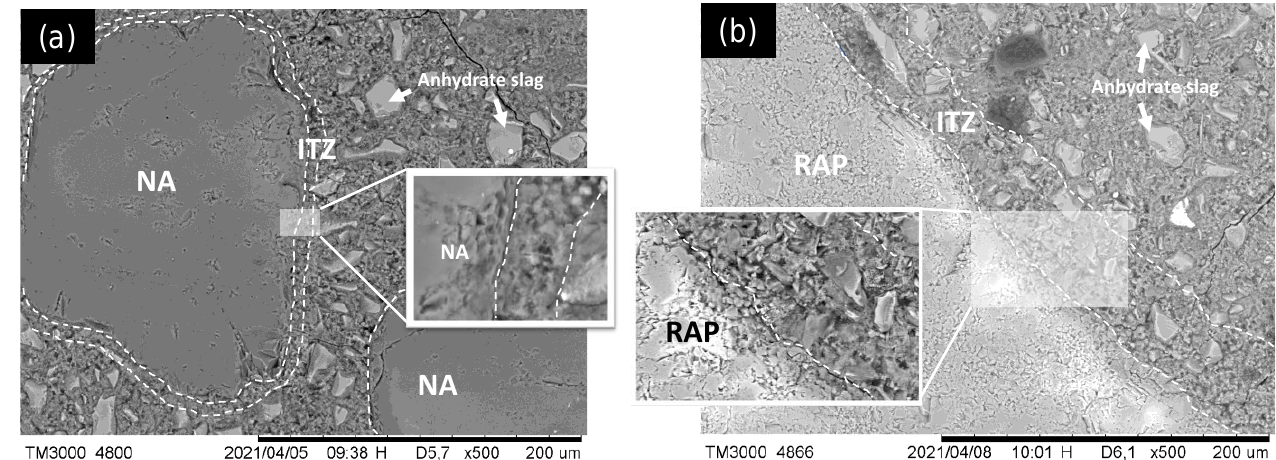
Figure 15. SEM Images ( a ) N4M1, ( b )R4M1.